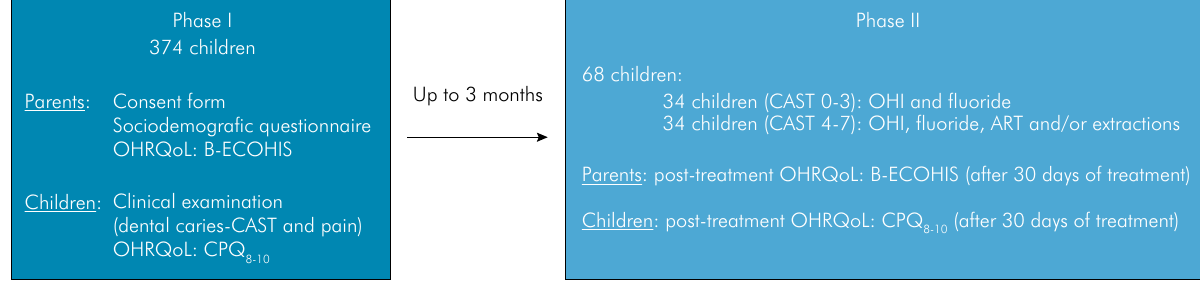
Figure. Flow chart for Phase I and Phase II, with sample size and evaluated